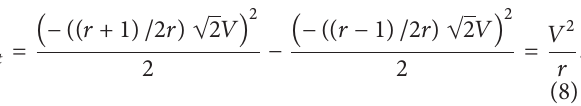
Figure 4: StBG of the 𝑉𝑅